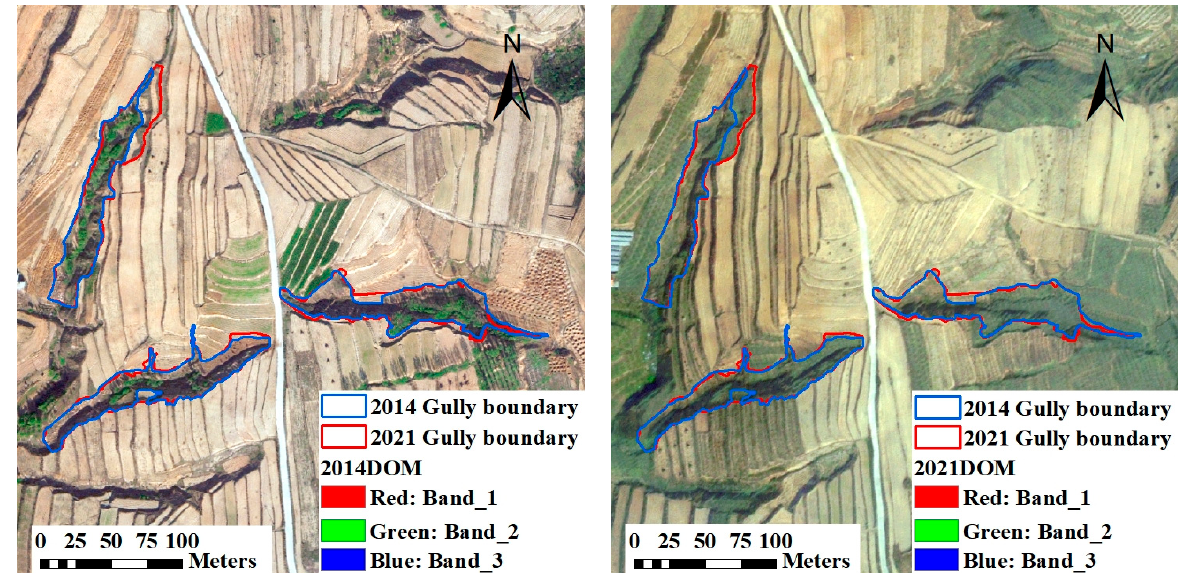
Figure 6. An example of gully length increase. Table 2. Annual variation in gully length during 2014–2021 ( n = 28).